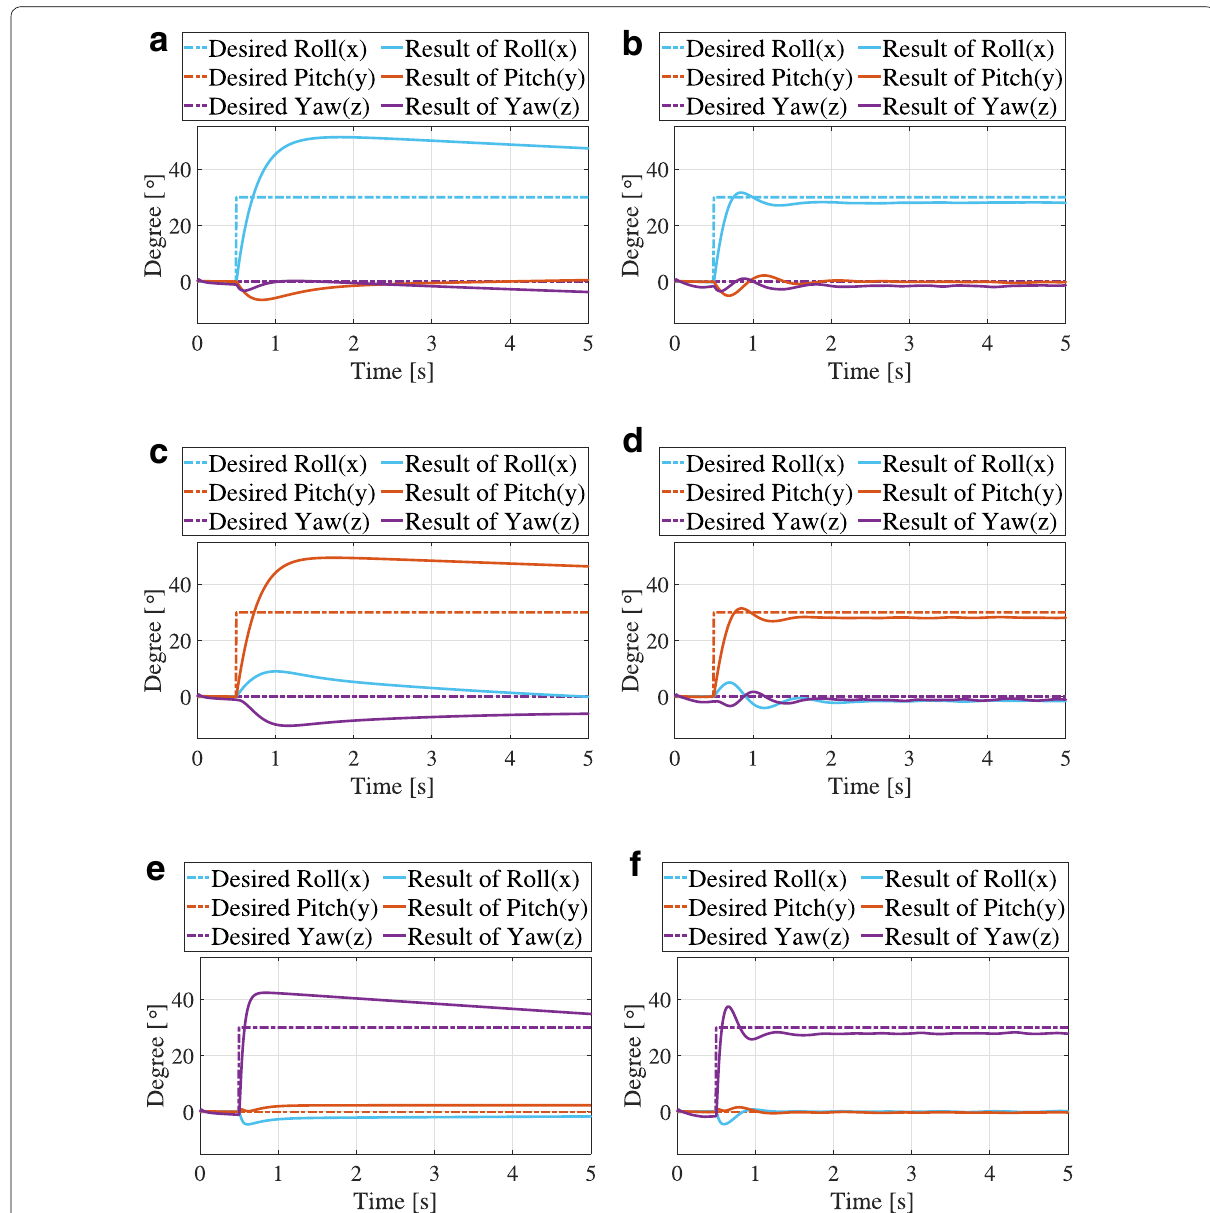
Fig. 17 Simulation results of the object orientation control: ( a , c , e ) indicate the actual object orientation using Tahara’s method (without using the visual‑tactile sensor), ( b , d , f ) indicate the actual object orientation using the proposed method (using the visual‑tactile